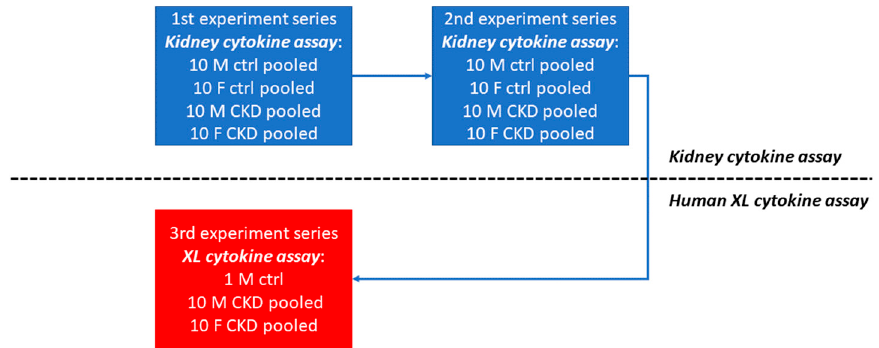
Figure 1. Workflow for the identification of CKD biomarkers. The pipeline employed the Human Kidney Biomarker Array in phase 1 of experiment series 1 and 2 and the human XL cytokine assay in phase 2 with experiment series 3. Pools of 10 male and 10 female urine samples were used for CKD patients and healthy controls.